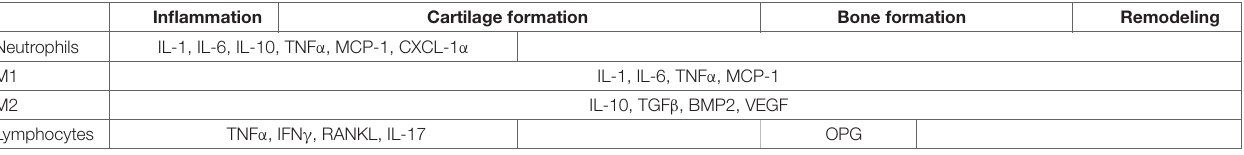
TABLE 3 | Secreted factors and relevant immune cells in bone fracture healing. Inflammation Cartilage